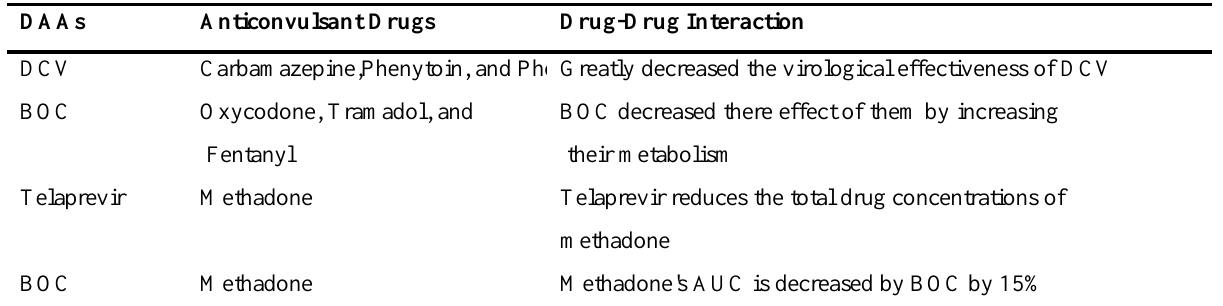
Table 2. Drug-Drug interactions between DAAs and Anticonvulsant drugs DAAs Anticonvulsant Drugs Drug-Drug